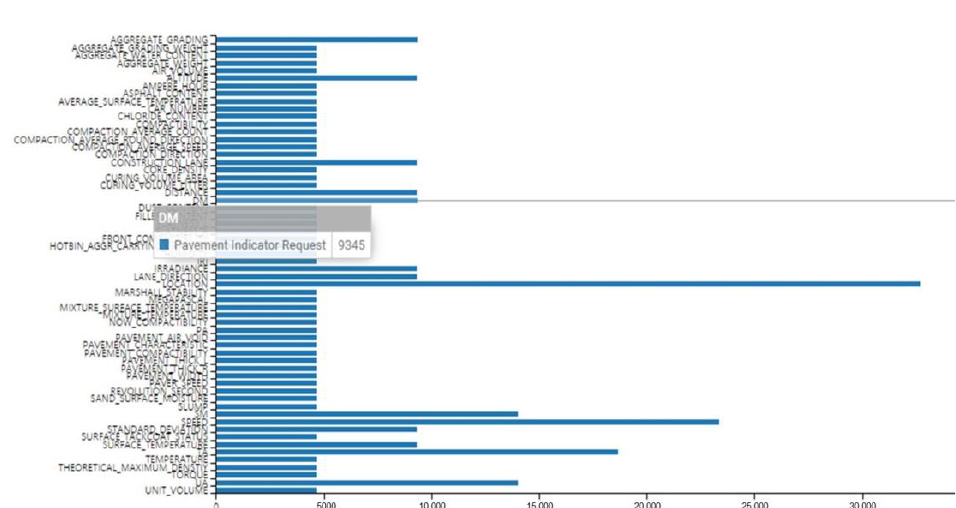
Figure 15. Traffic per minute.